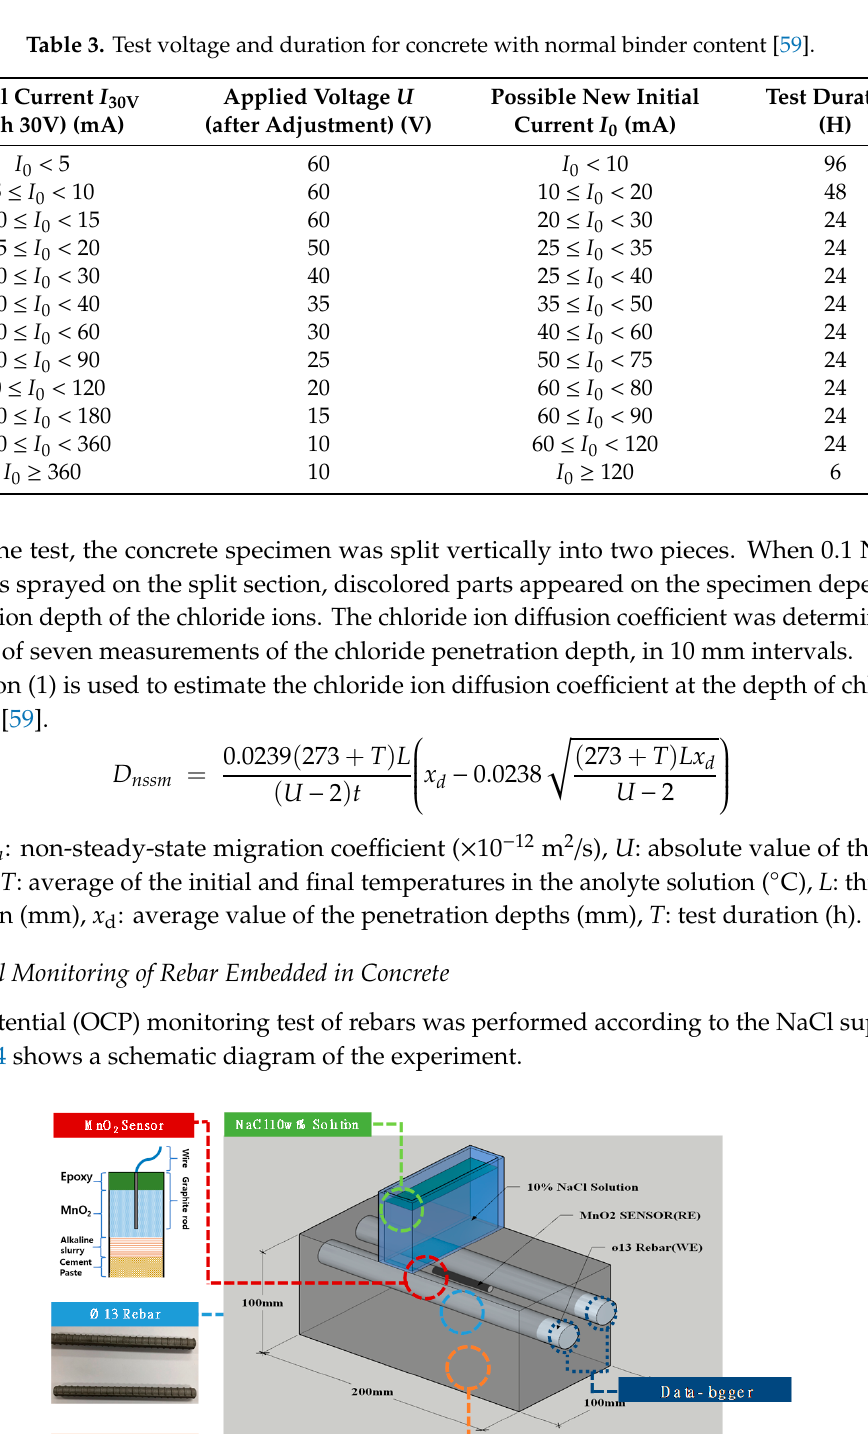
Table 3. Test voltage and duration for concrete with normal binder content [59].